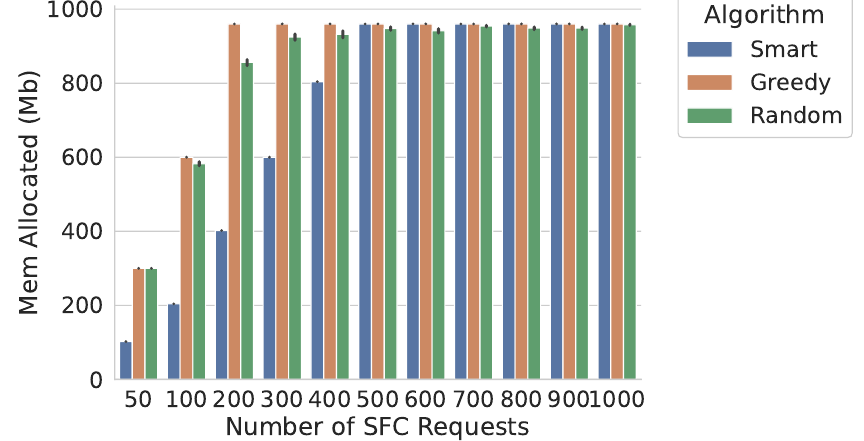
Figure 10. Allocated memory